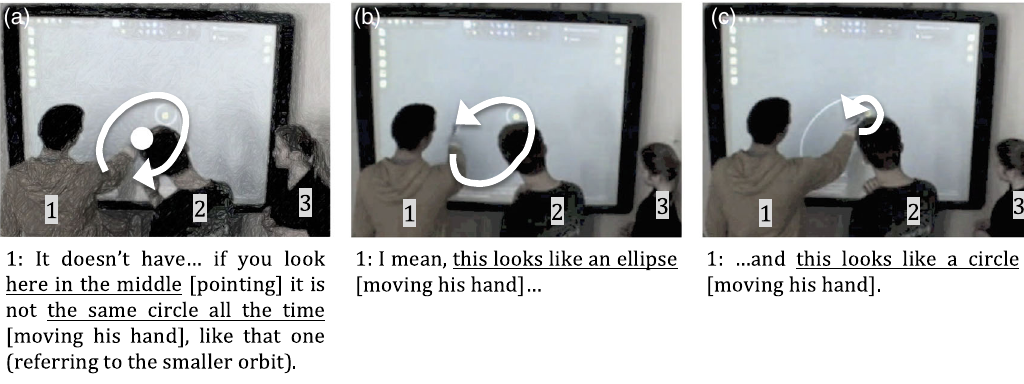
FIG. 3. In (a), student 1 is pointing to the “ center ” of the more pronounced (more eccentric) ellipse. In (b) and (c), he refers to the two differently shaped orbits, stating that “ this one ” (b) looks like an ellipse, and “ this one ” (c) looks like a circle. In this case (b),(c), the gestures represent the geometrical properties of the two orbits. Functionally, the symbiotic gestures shown here are employed by the student to express some discerned variation in the observed phenomena of